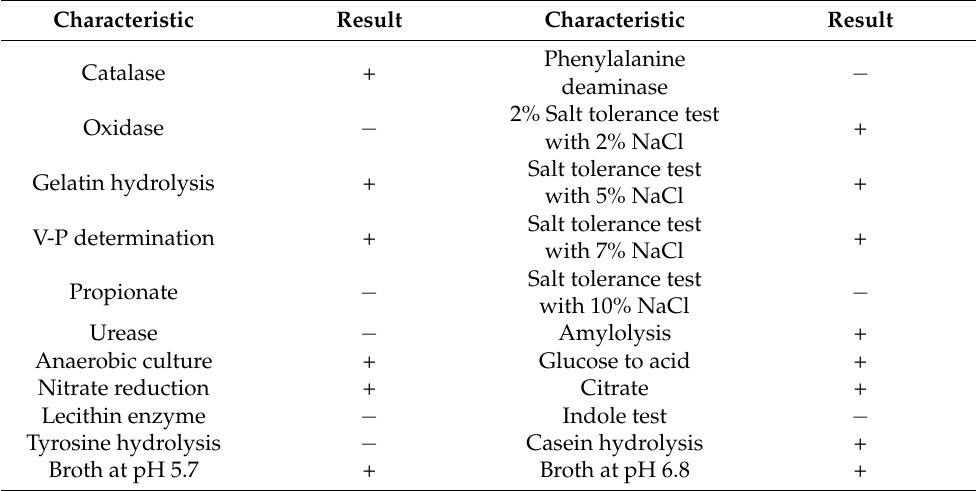
Figure 1. Isolation and characterization of a new antagonistic strain, F9, against X. citri subsp. citri. ( A ) Agar diffusion assay. The strain F9 showed an antagonistic effect against Xcc jx-6. ( B ) Colonies of antagonistic strain F9 grown on LB agar plates at 30 °C for 24 h. ( C ) The cells of strain F9 were observed by transmission electron microscopy. ( D ) Agarose gel electrophoresis analysis of the β - mannanase gene of Bacillus subtilis and Bacillus amyloliquefaciens . ( E ) Analysis of the phylogenetic tree of strain F9 based on 16S rDNA gene sequences and related bacteria with the neighbor-joining method with a bootstrap value of 1000 replicates. The bar indicates an estimated sequence divergence of 2%. Table 1. The biochemical and physiological characteristics of strain F9.